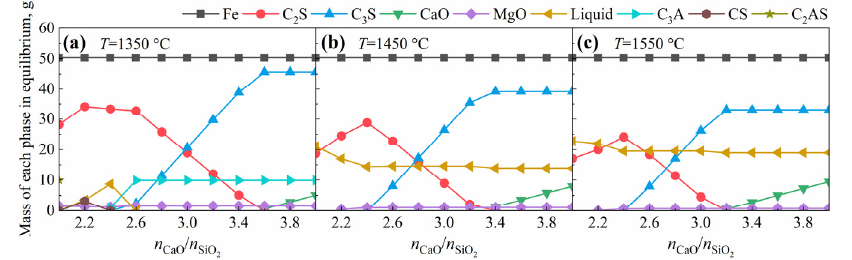
Figure 12. The effect of iron on the formation of cementitious materials: ( a ) T = 1350 °C; ( b ) T = 1450 °C; ( c ) T = 1550 °C.